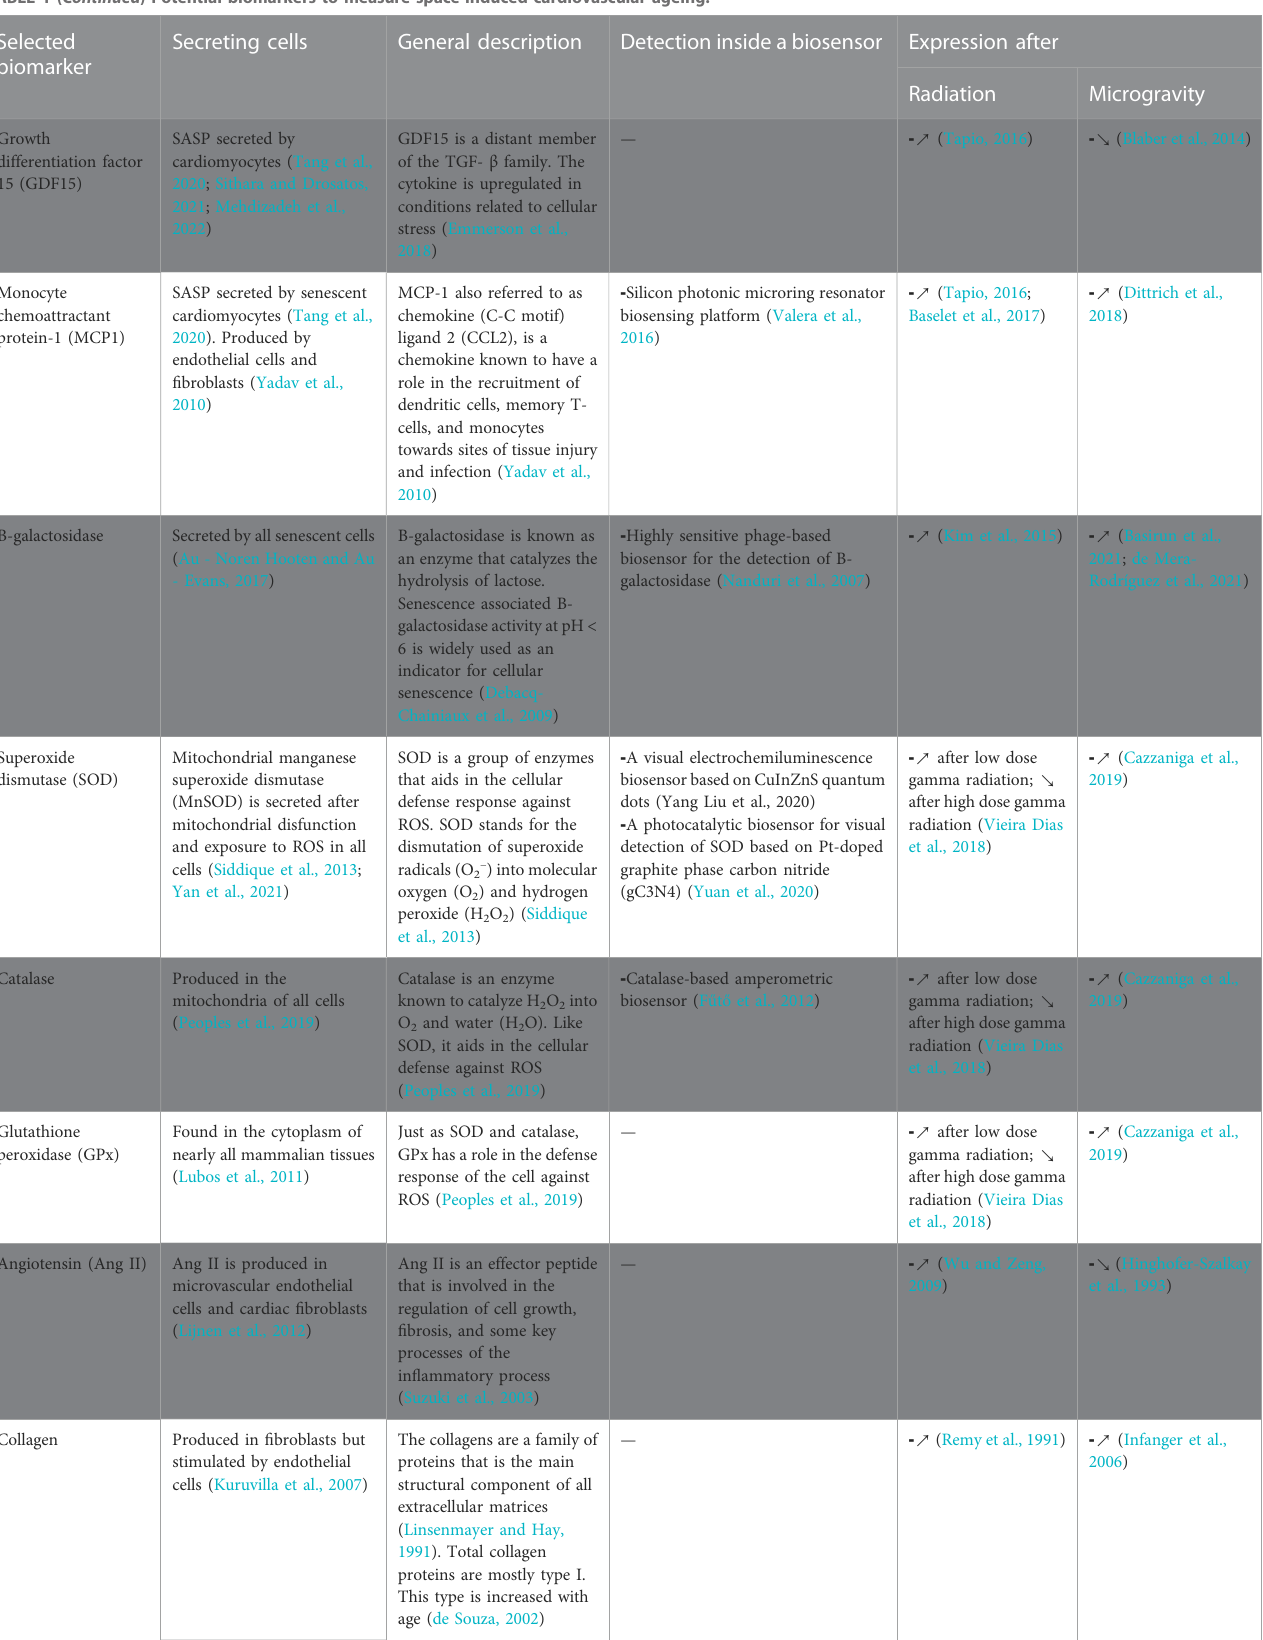
TABLE 1 ( Continued ) Potential biomarkers to measure space-induced cardiovascular